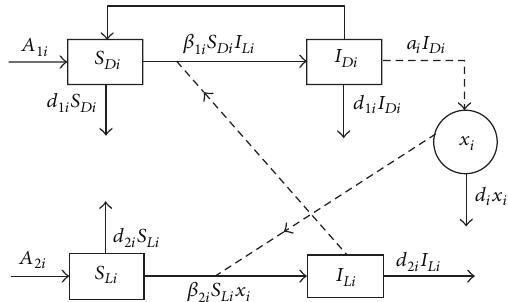
Figure 1: Transmission diagram for echinococcosis among dogs,